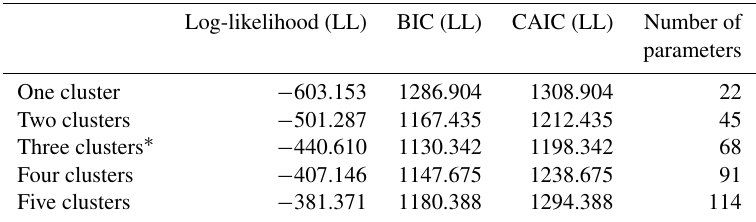
Figure 5. ISVI values and its decomposition into vulnerability components. Source: municipal boundaries (available online: http://www.ign. es; accessed on 5 December 2016). Table 3. Model fit summary of the latent class cluster models initially